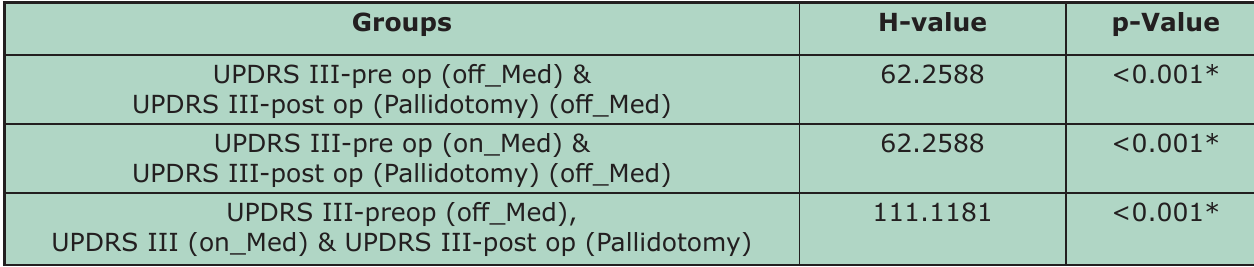
Table-IV: Kruskal-Wallis Test.